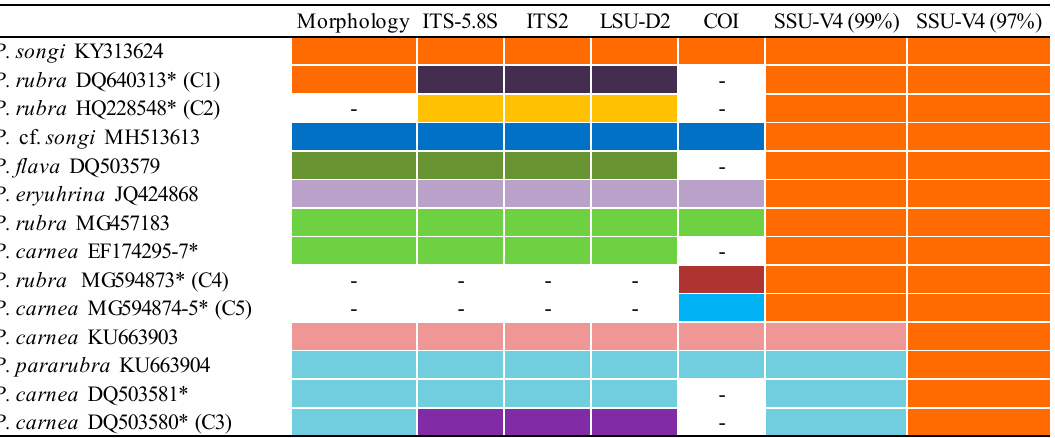
Figure 2. Horizontal bars show the species delimitation results inferred from the morphology and molecular markers (listed on the upper side) for Pseudokeronopsis species. Each color represents a species (online version in color). C1–C5 correspond to the C1–5 taxa marked in the following phylogenetic trees. Dashed line indicates no available data. *, misidentified species.